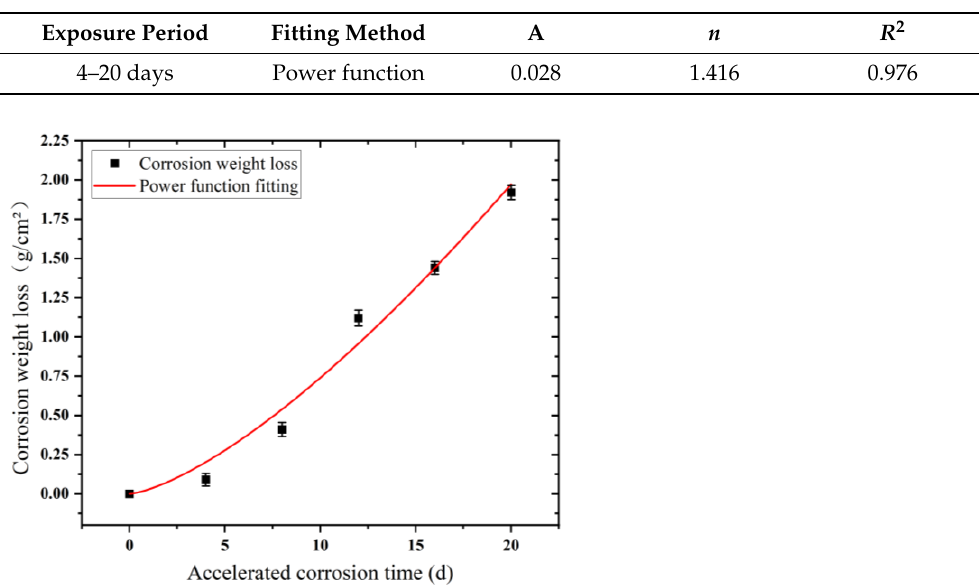
Figure 13. Corrosion weight loss fitting curves of Q235 low-carbon steel samples in accelerated cor- rosive